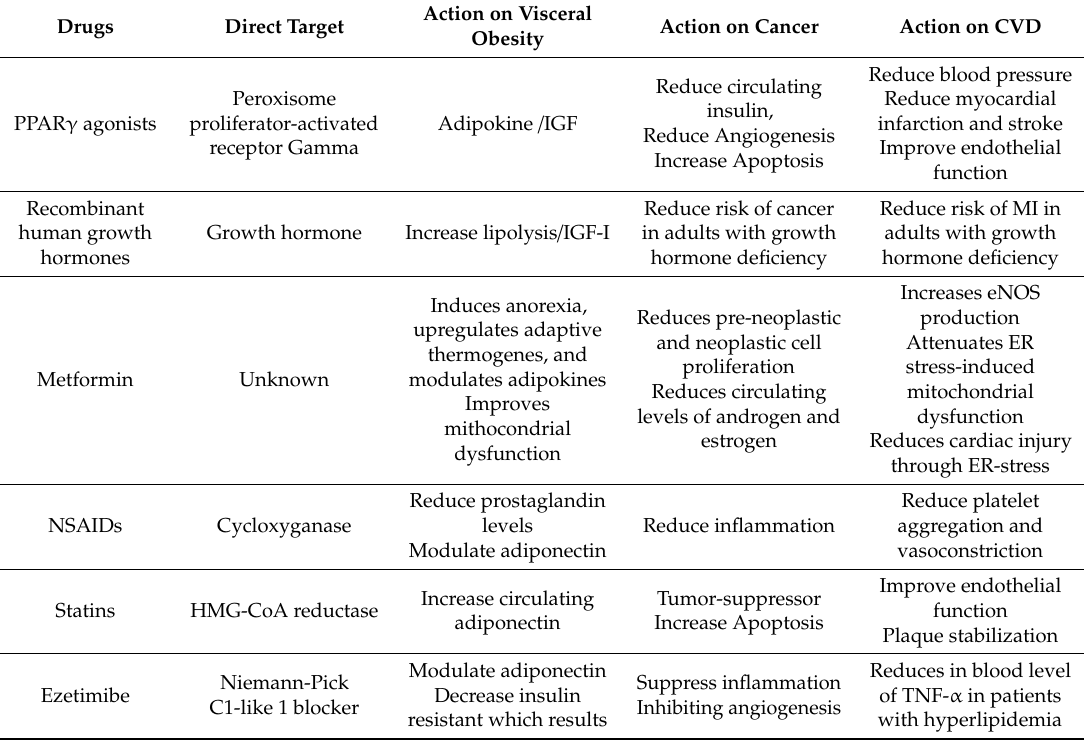
Table 2. Drugs for joint pharmacologic prevention of visceral obesity, cardiovascular disease and